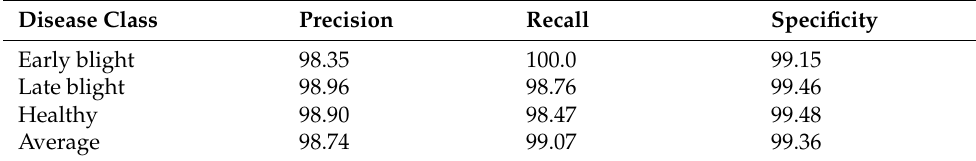
Table 6. Performance evaluation of individual classes of potato diseases using VGG and Xgboost.